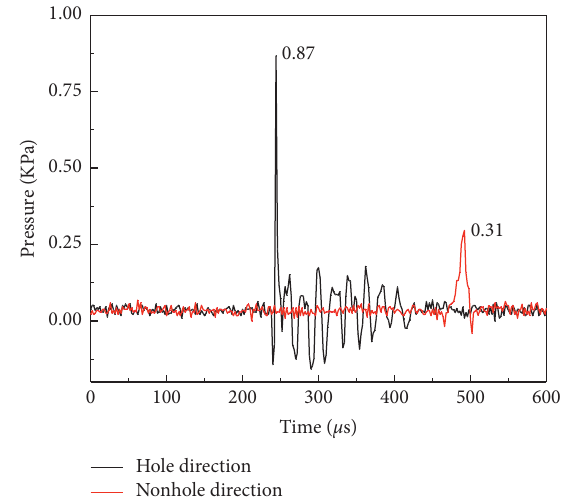
Figure 8: Overpressure results from two directions (hole and nonhole directions).